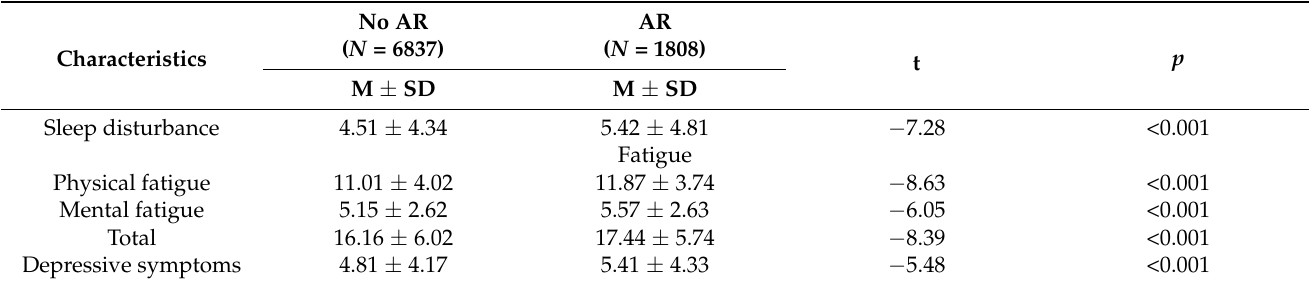
Table 2. Sleep disturbance, fatigue, and depressive symptoms according to allergic rhinitis ( N = 8645).